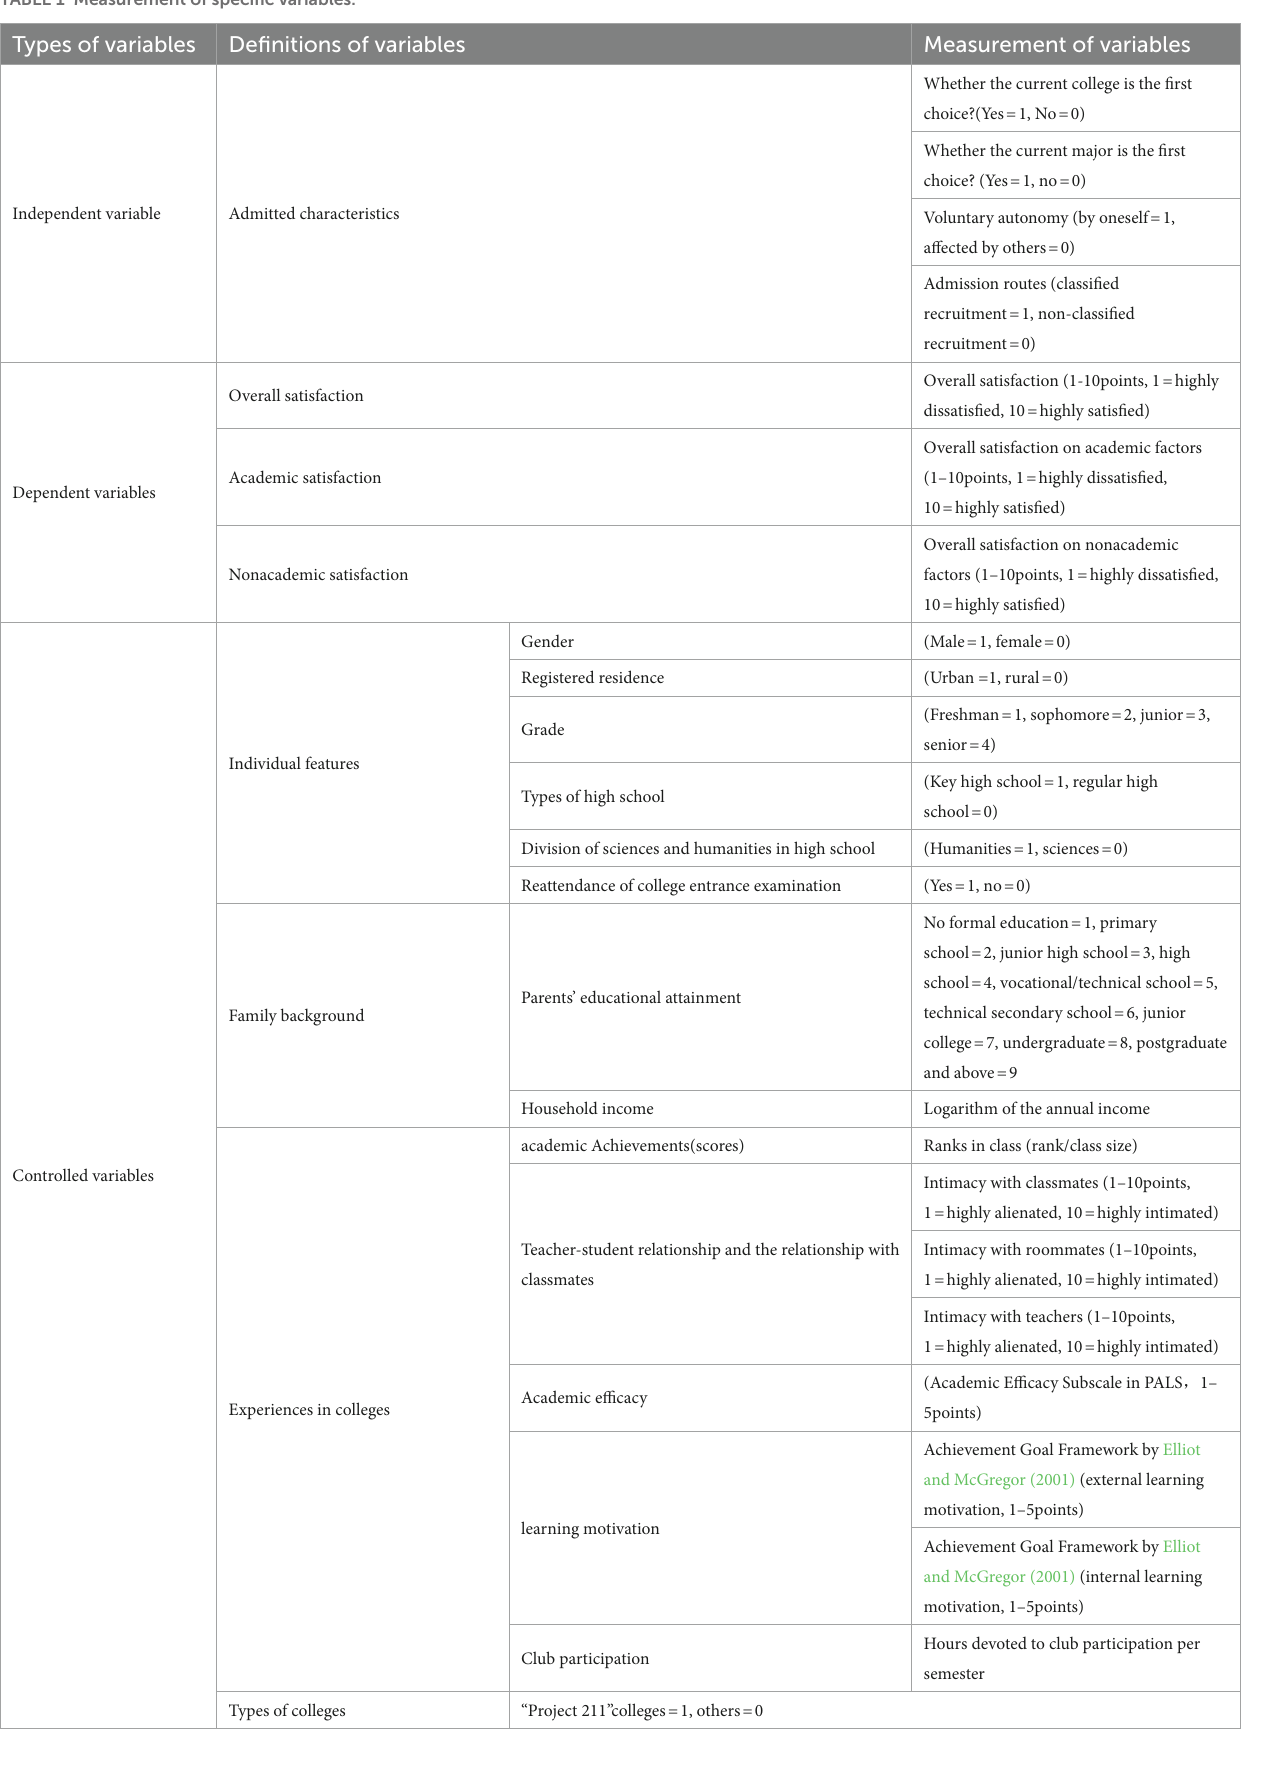
TABLE 1 Measurement of specific